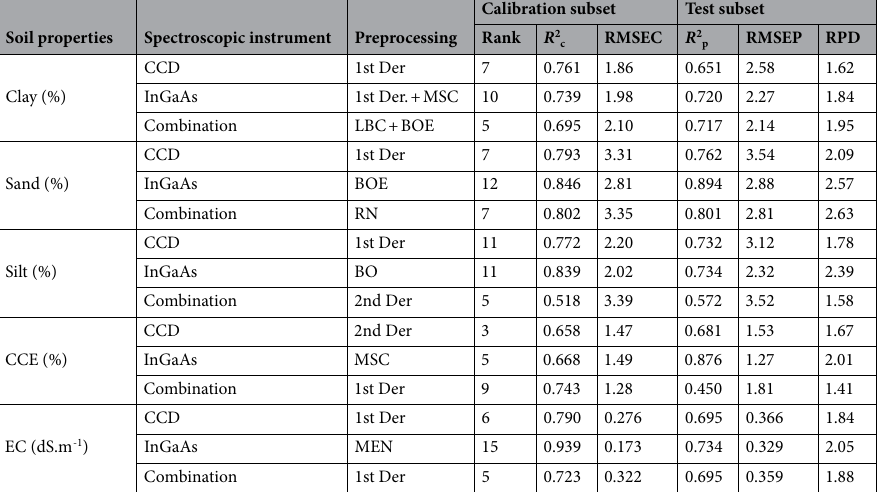
Table 3. Calibration and estimation PLS results of selected soil physicochemical properties using spectral data of CCD and InGaAs spectroscopic instruments, and the combination data of both. BOE baseline offset elimination, CCD charge-coupled device, CCE calcium carbonate equivalent, EC electrical conductivity, InGaAs indium gallium arsenide, LBC linear baseline correction, MEN mean normalization, MSC multiplicative scatter correction, R 2 c coefficient of determination in calibration, R 2 p coefficient of determination in prediction, RMSEC root mean square error of calibration, RMSEP root mean square error of prediction, RN range normalization, RPD residual predictive deviation, 1st Der. : first derivative, 2nd Der. second